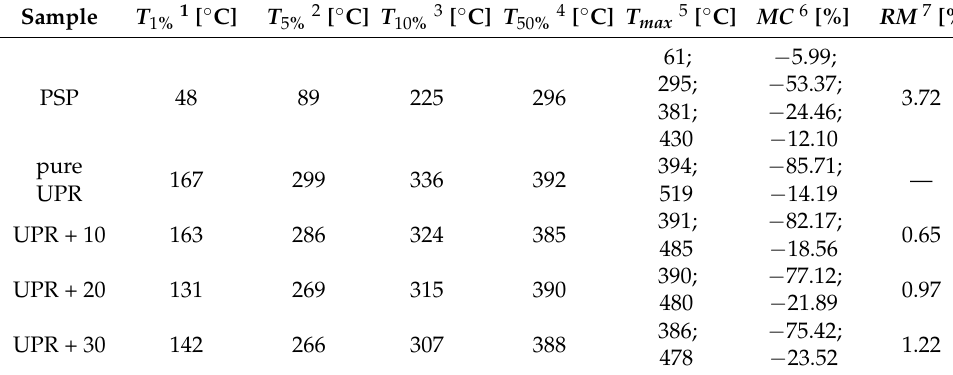
Table 3. Thermogravimetric analysis data for the UPR/PSP composites.